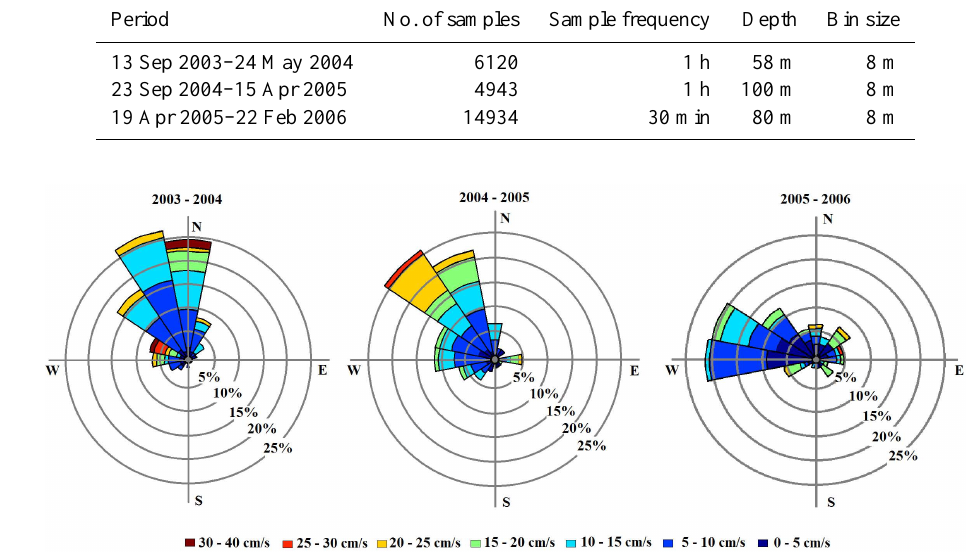
Fig. 2. Distribution of the horizontal currents recorded at 40m depth from October to February during the three deployments.